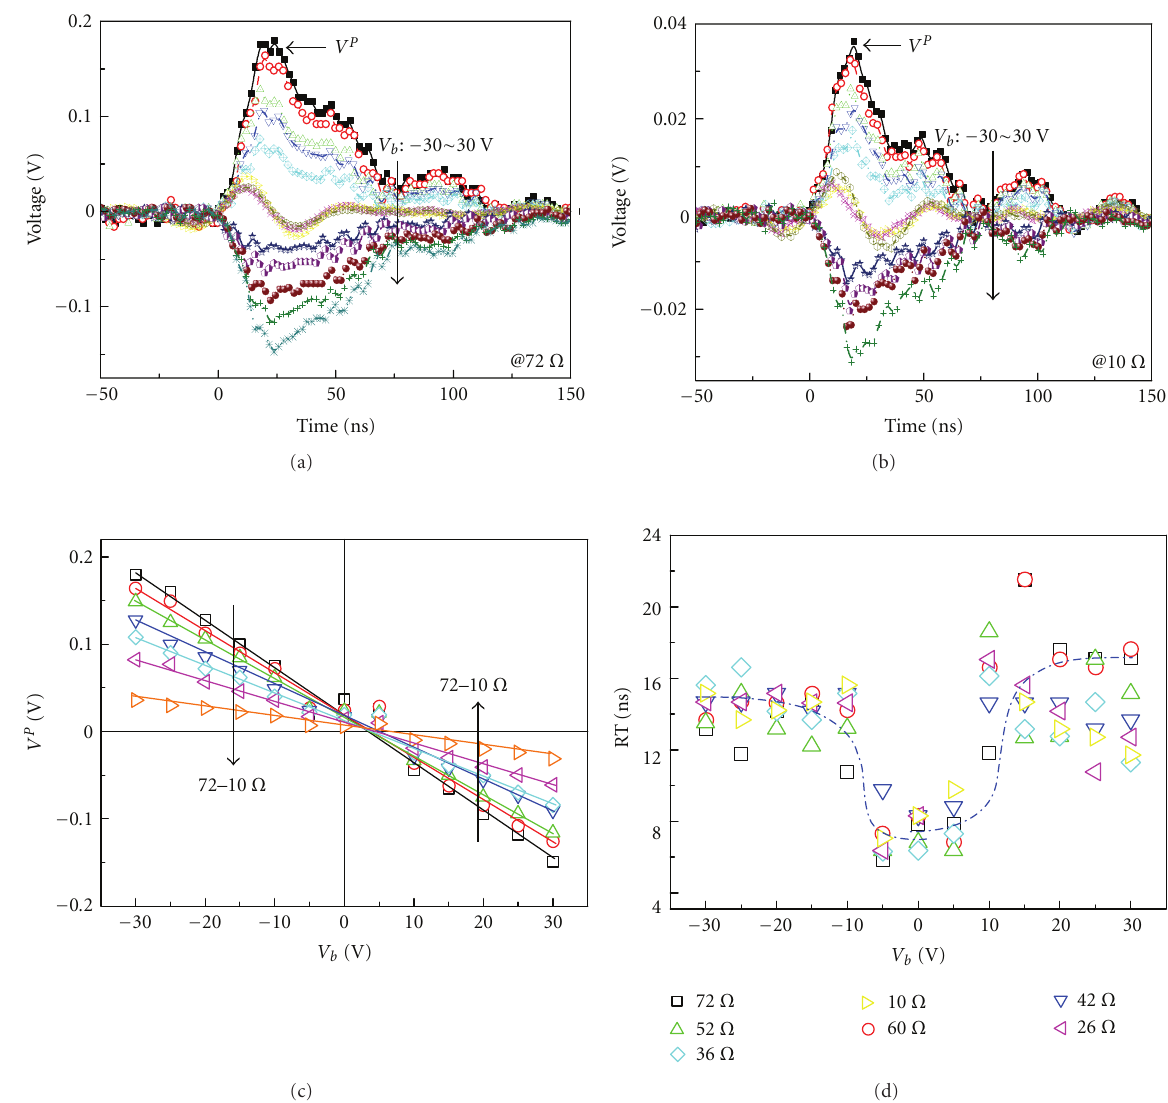
Figure 3: Photovoltage as a function of time with (a) R S = 72 Ω and (b) R S = 10 Ω under 248 nm laser pulses at di ff erent bias voltage V b . (c) V P and (d) rise time RT as a function of V b